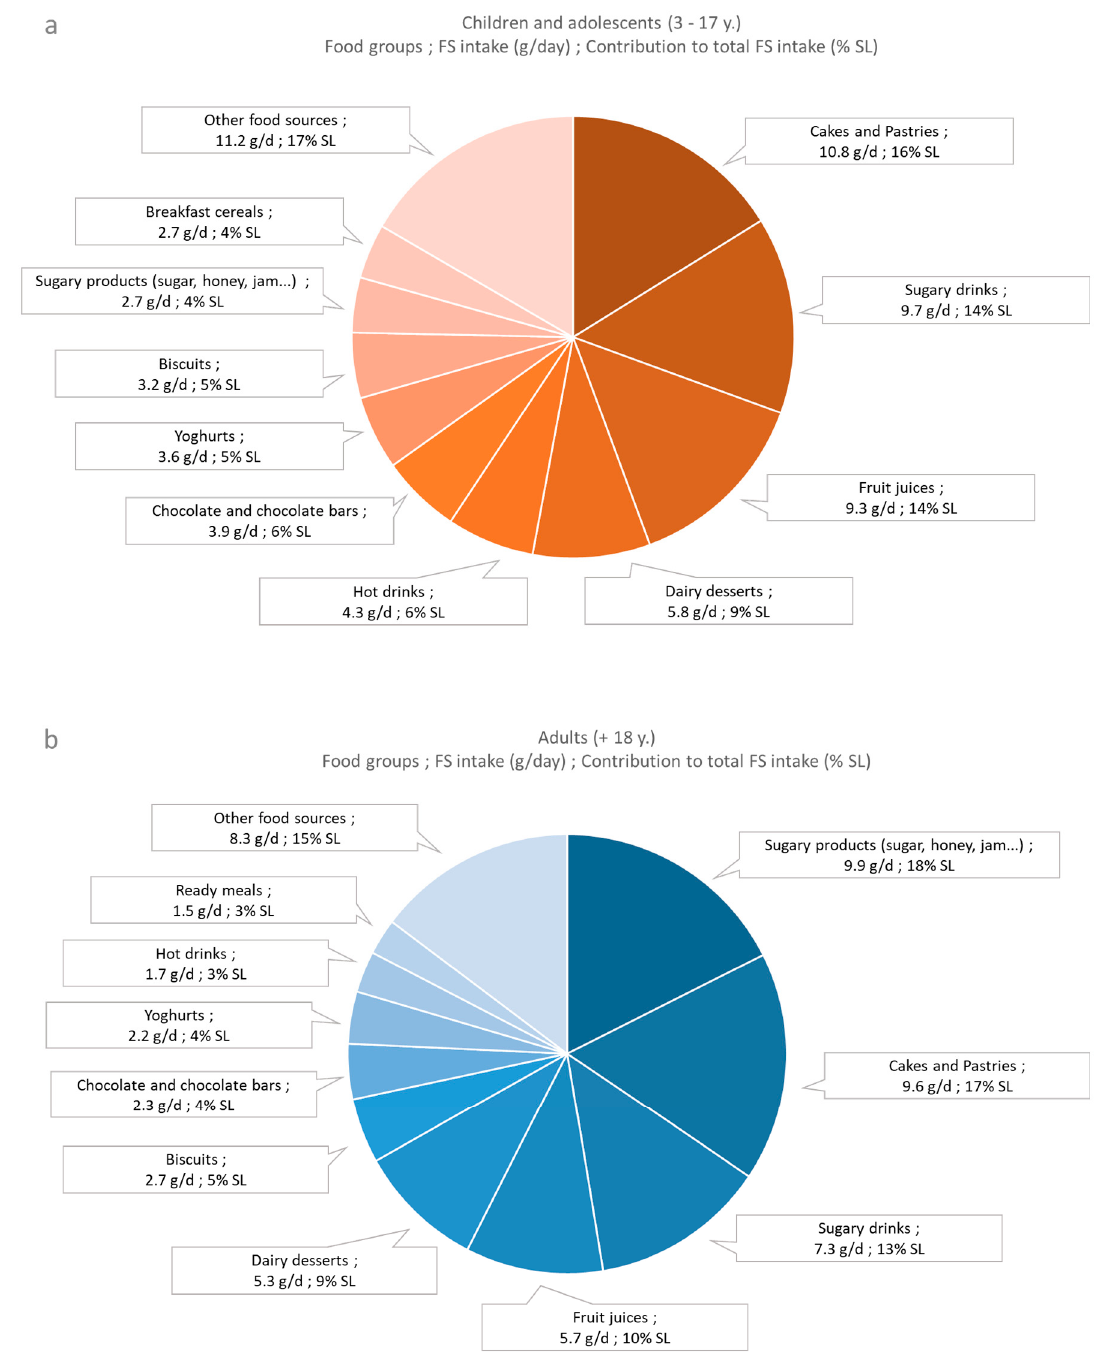
Figure 1. Contribution of the most important food groups to overall intake of free sugars intake presented as kcal per day (kcal/day) and% of total free sugars intake (%TFS) in children and adolescents ( a ) as well as adults ( b ).